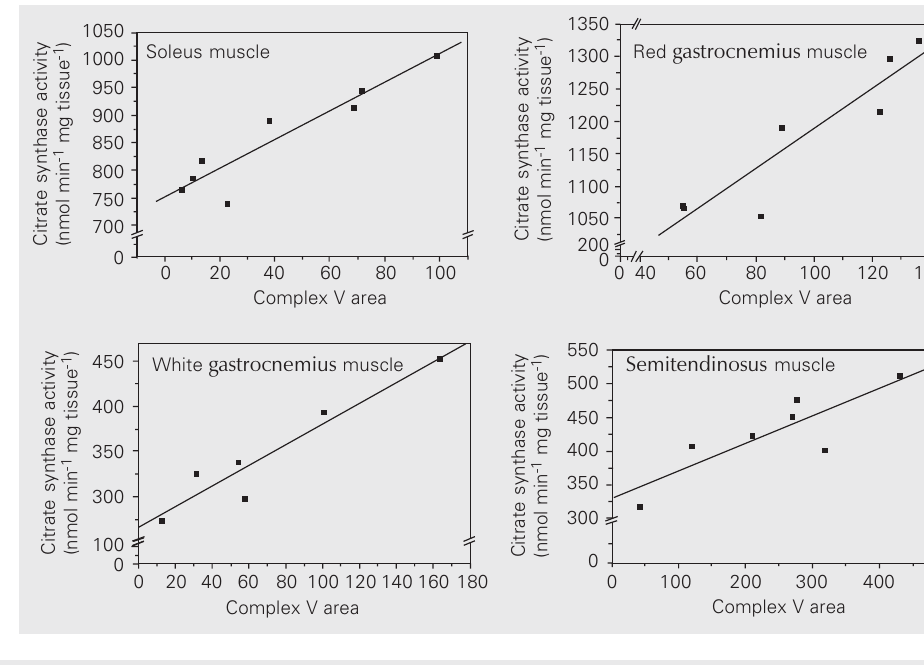
muscleFigure 2. Correlation between the complex V area and citrate synthase activity of different rat muscles. The area of complex V is reported in arbitrary units. So- leus muscle, N = 8, P = 0.006, r = 0.94; red gastrocnemius muscle, N = 7, P = 0.003, r = 0.92; white gastrocnemius muscle, N = 6, P = 0.003, r =